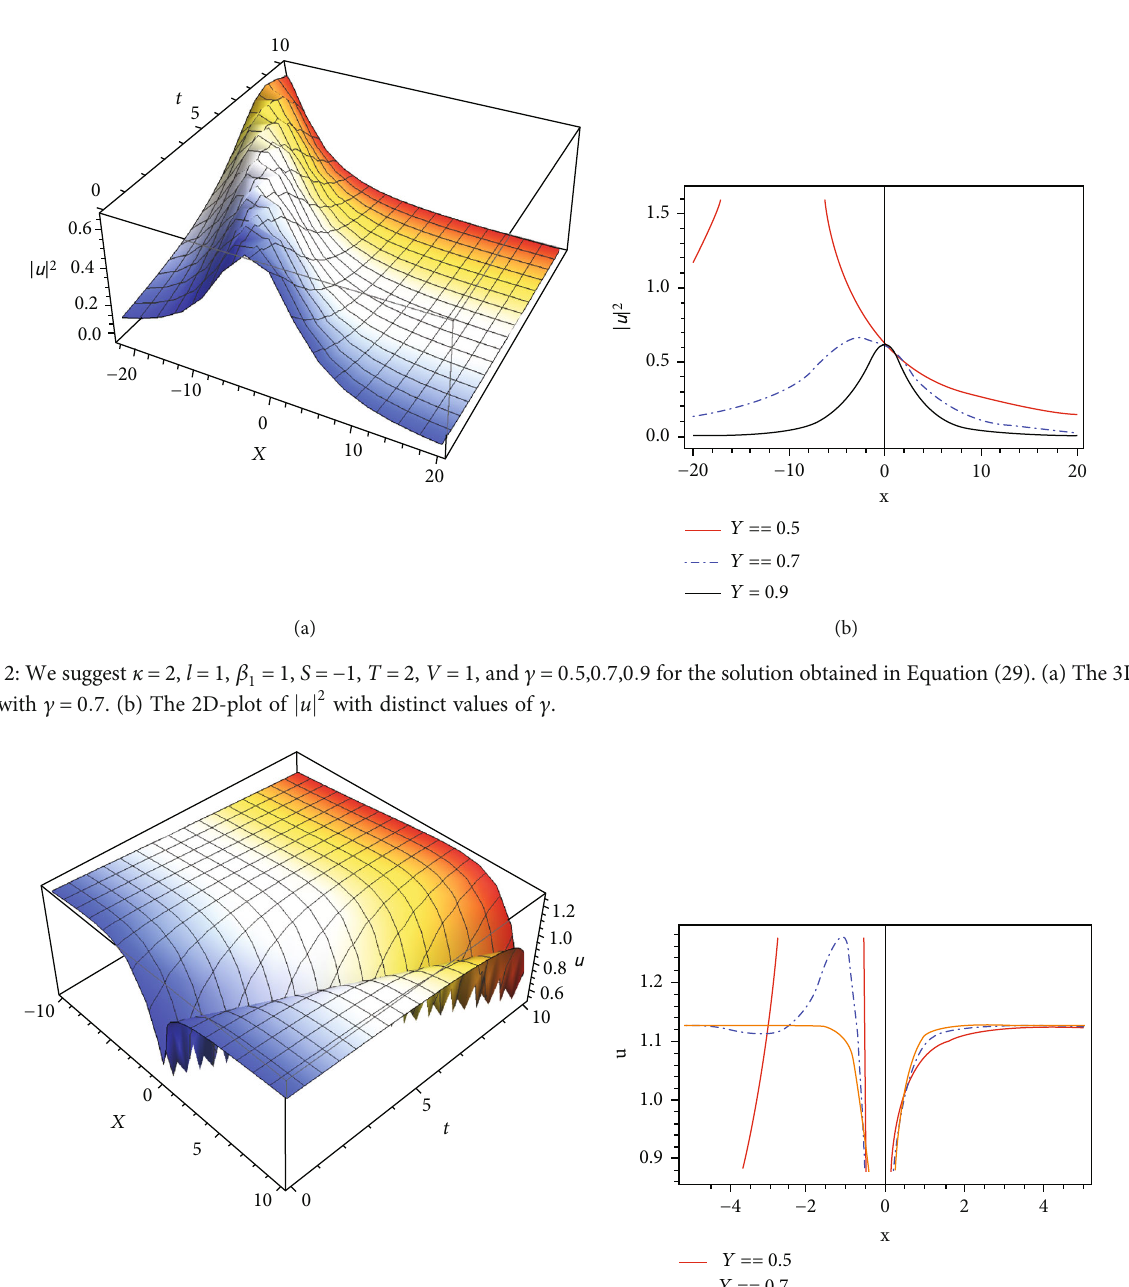
u ð x , t Þ 1,1 . (a) The 3D graph of 1,1